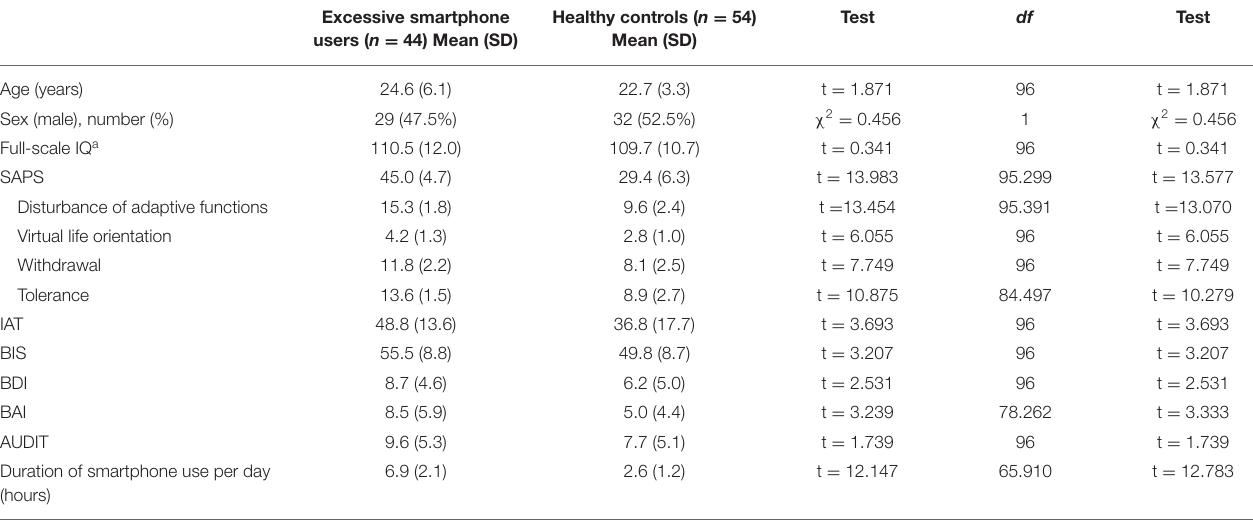
TABLE 1 | Demographics and clinical characteristics of study participants.